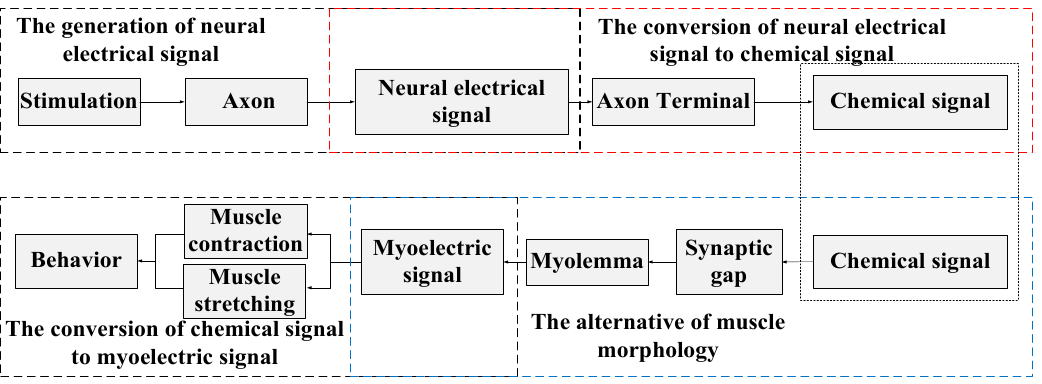
Sensors 2020 , 20 , x FOR PEER REVIEW Figure 1. The movement mechanism of beetles. Figure 1. The movement mechanism of beetles.